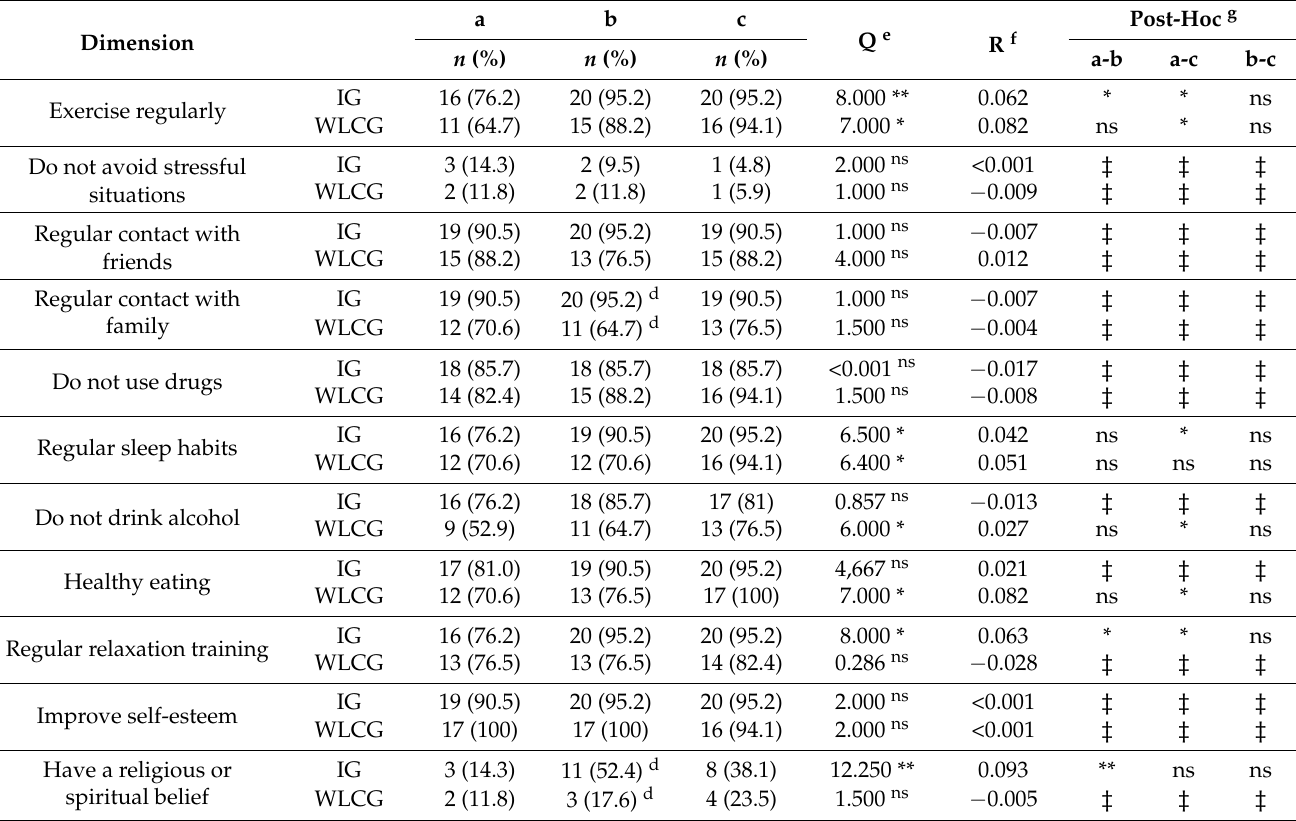
Table 3. Findings for “anxiety prevention strategies” in the three assessments by